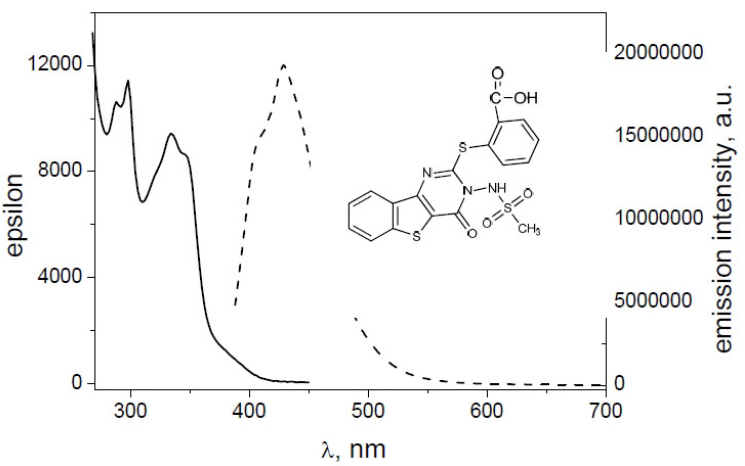
Figure 8. Absorbance (straight line) and emission (dashed line) spectra of 10 .